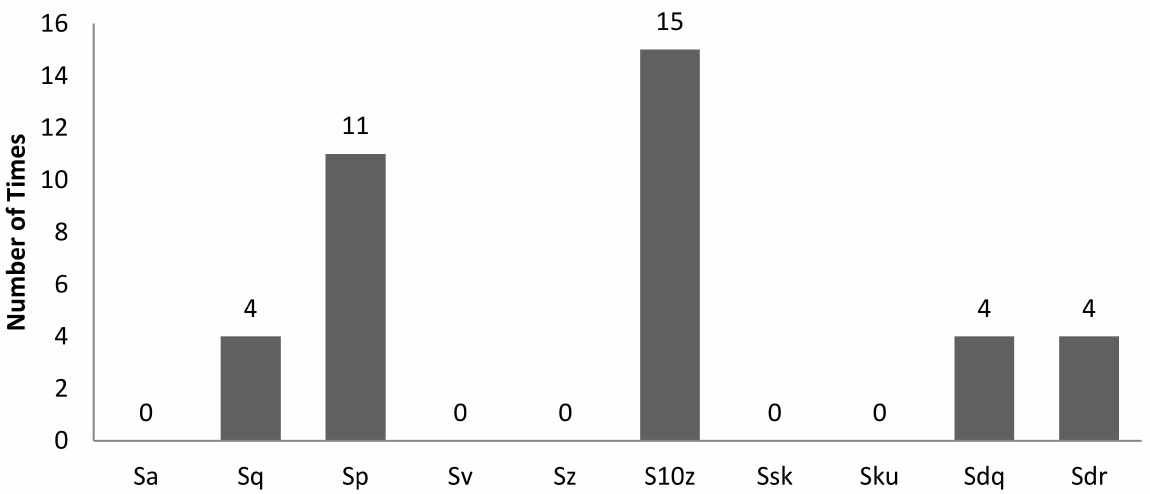
Figure 9. Bar chart showing the number of times a 3D surface roughness parameter was involved in correlation with R 2 ≥ 0.7 for an illumination angle of 30 ◦ for experimental setup 1.